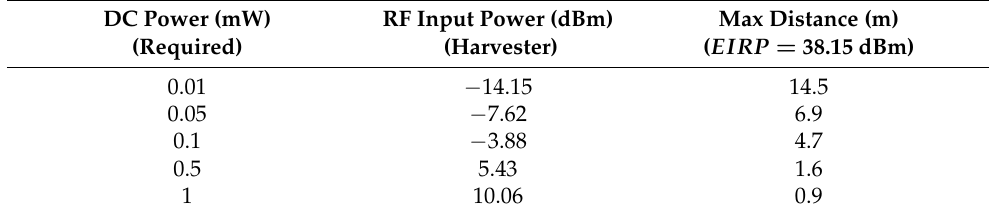
Table 2. Maximum harvesting distance 38.15dBm EIRP related to varying DC output power